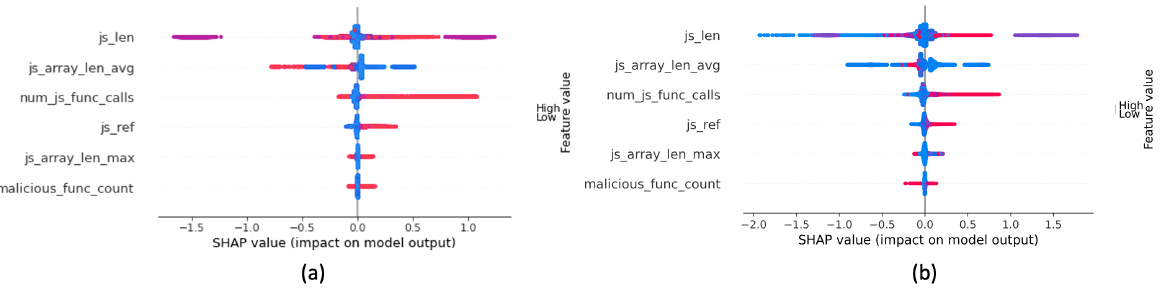
Figure 8. Two summaries of SHAP values: ( a ) full dataset; ( b ) dataset containing only JavaScript code.